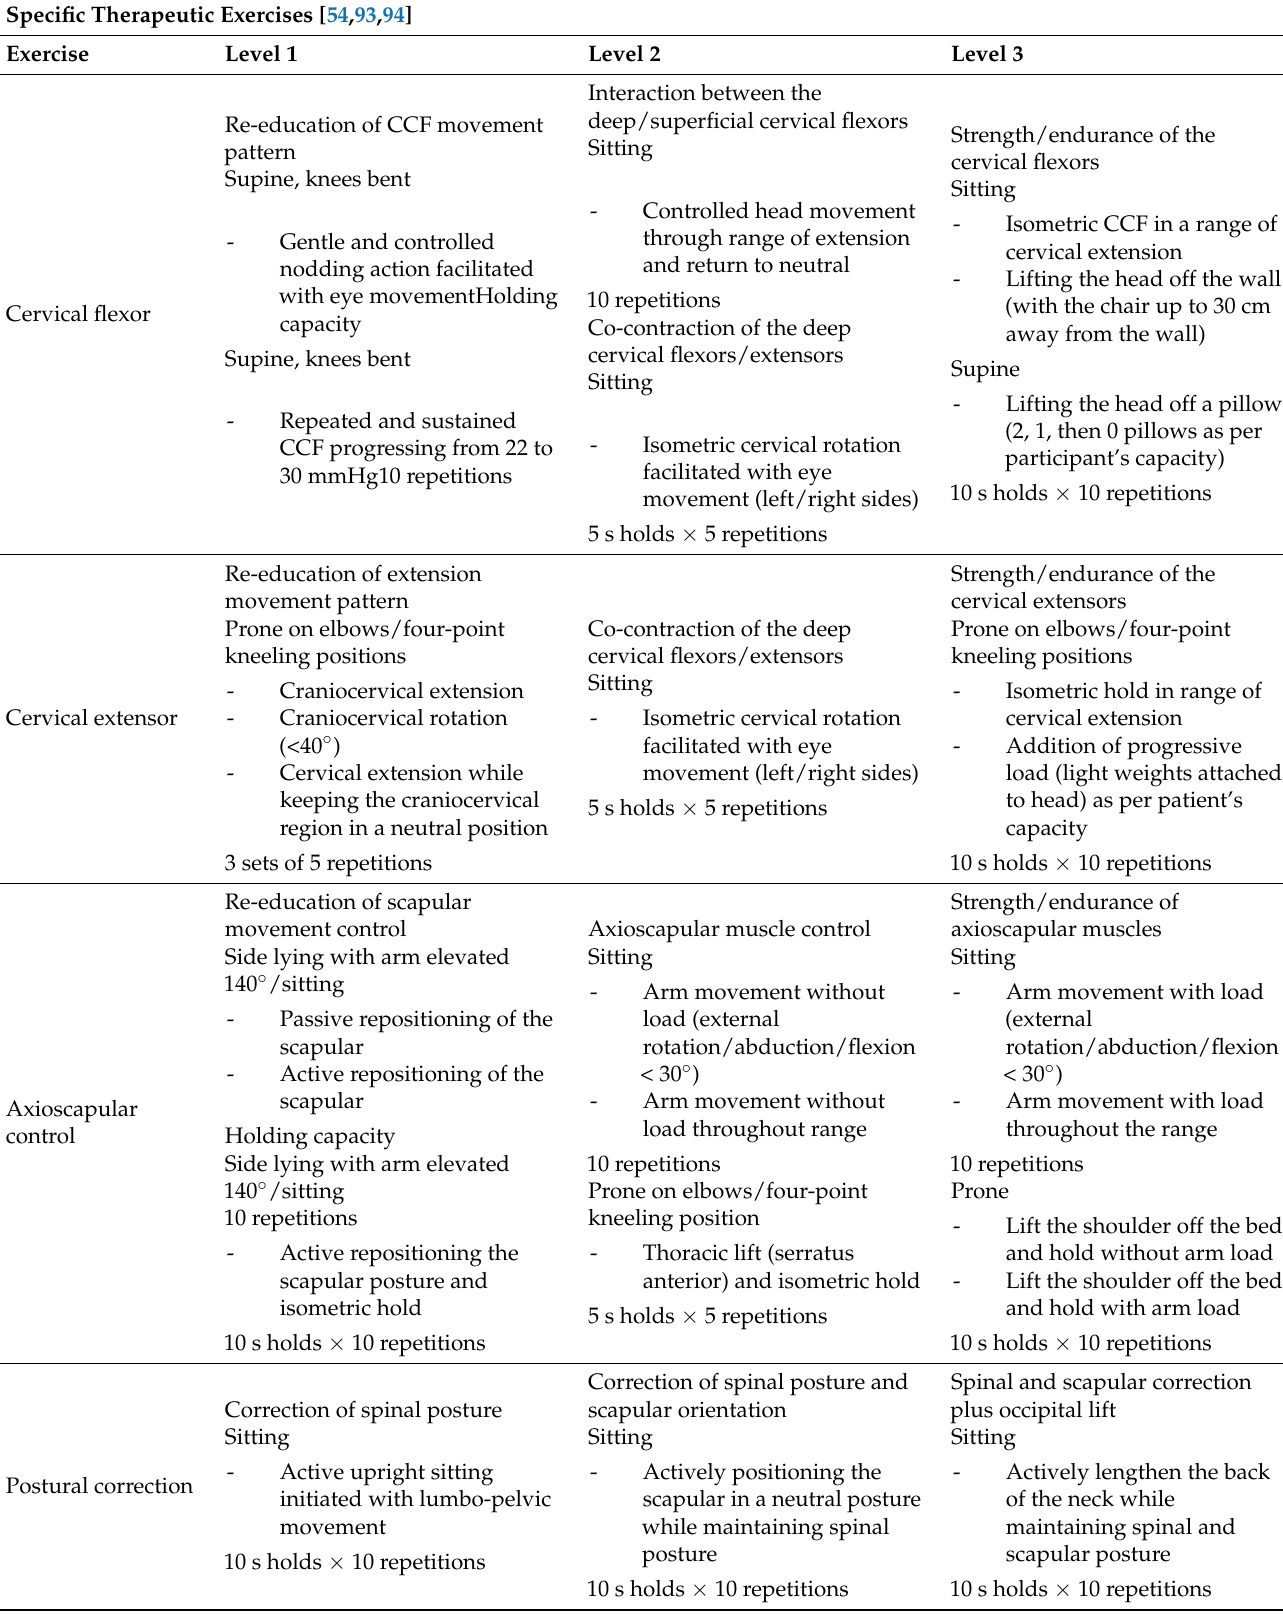
Table 5. Details of the specific therapeutic exercise